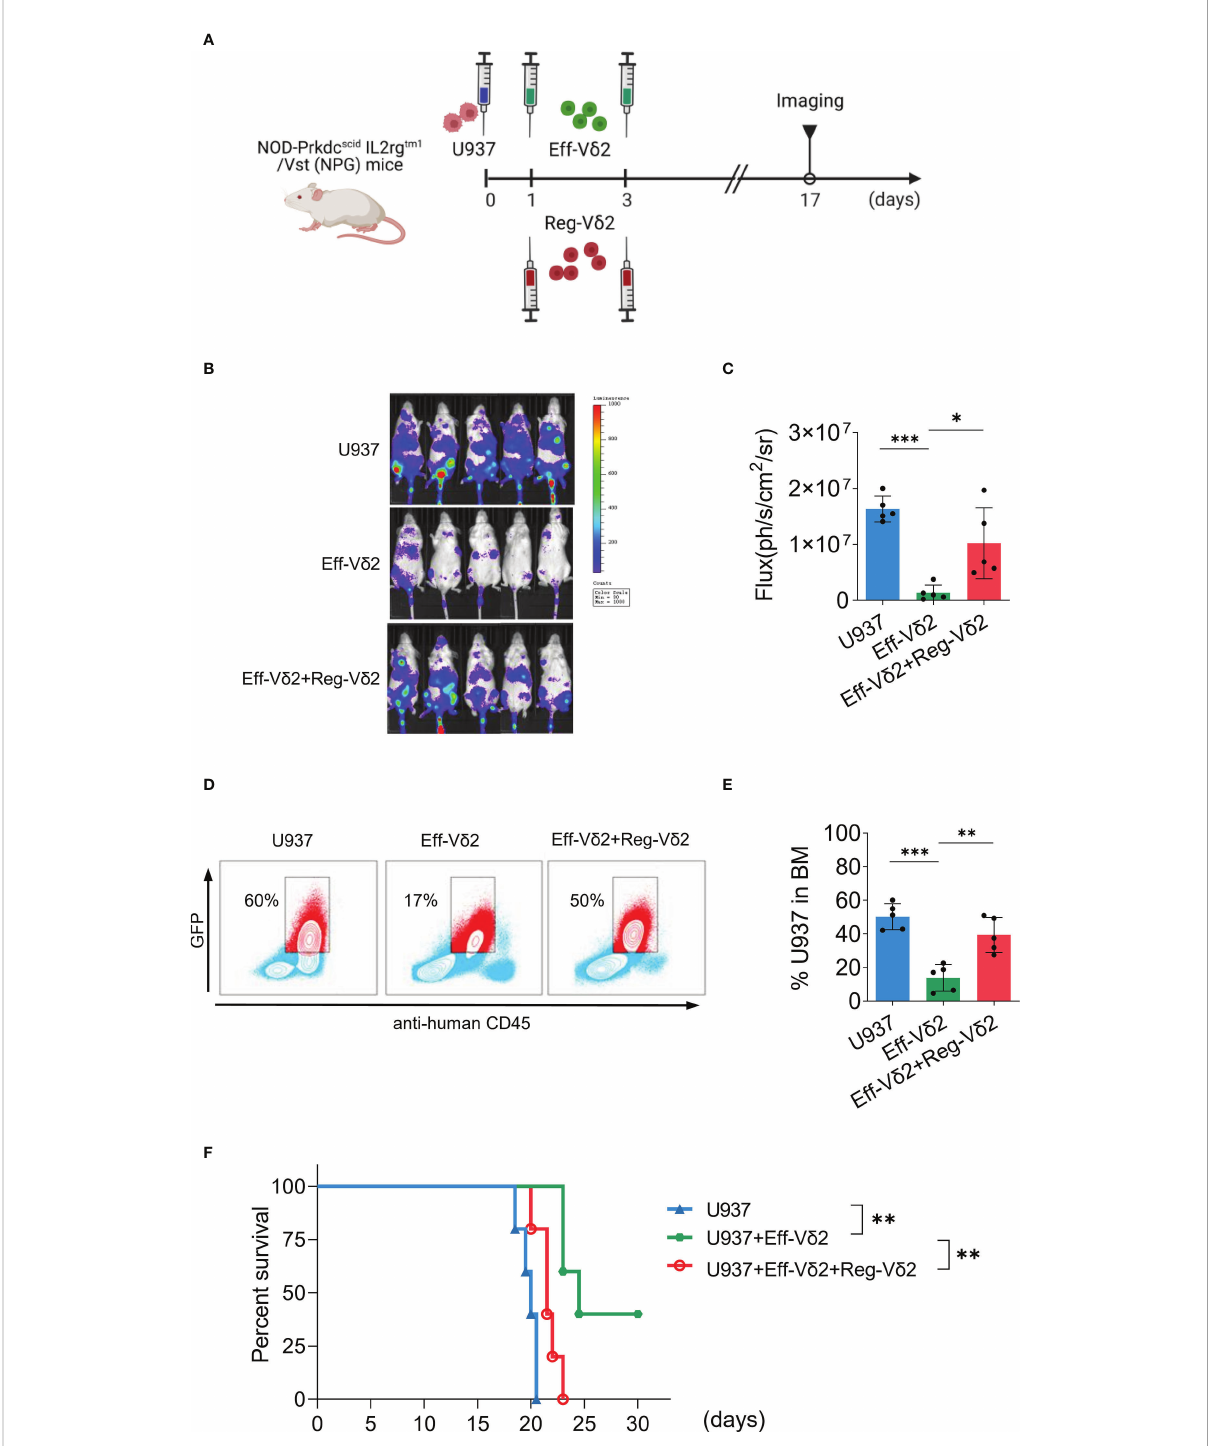
FIGURE 5 Impact of Reg-V d 2 cells on the anti-AML activity of effector V d 2 cells in mice. (A) Protocol for evaluating the direct in fl uence of Reg-V d 2 cells on the anti-AML activity of effector V d 2 cells (Eff-V d 2) in NPG mice. U937 cells co-expressing luciferase and GFP, and Eff-V d 2 cells with or without Reg-V d 2 cells were injected at indicated time points. Noninvasive whole-body imaging for the growth of U937 cells (B) and quanti fi cation of bioluminescence signal (C) in different groups of mice on day 17. (D, E) Representative dot-plot images of fl ow cytometry and the statistical analyses showing the frequencies of U937 cells in the bone marrows of mice with different treatments. (F) Survival of mice with different treatments until 30 days. n = 5, * P < 0.05, ** P < 0.01, *** P <